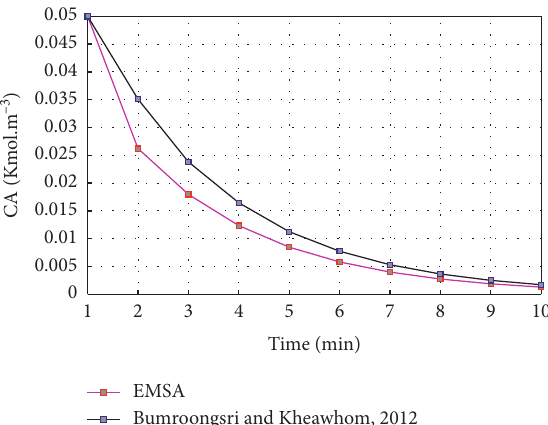
Figure 4: The concentration of A in the reactor of the regulated output obtained with EMPS algorithm.